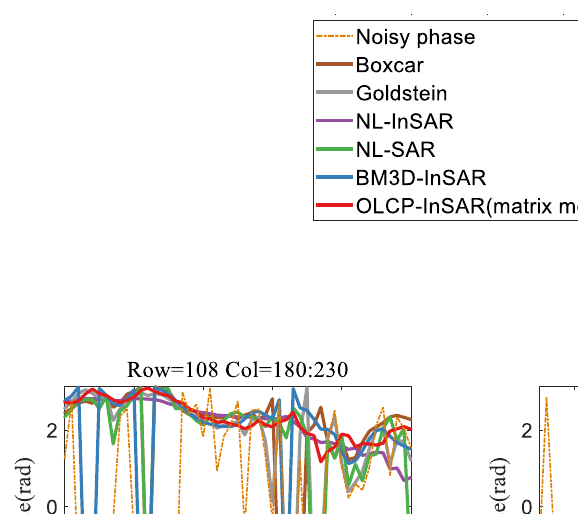
Figure 20. The filtered result of the fifth slice in the real InSAR tensor acquired by the filter operating on the matrix model.